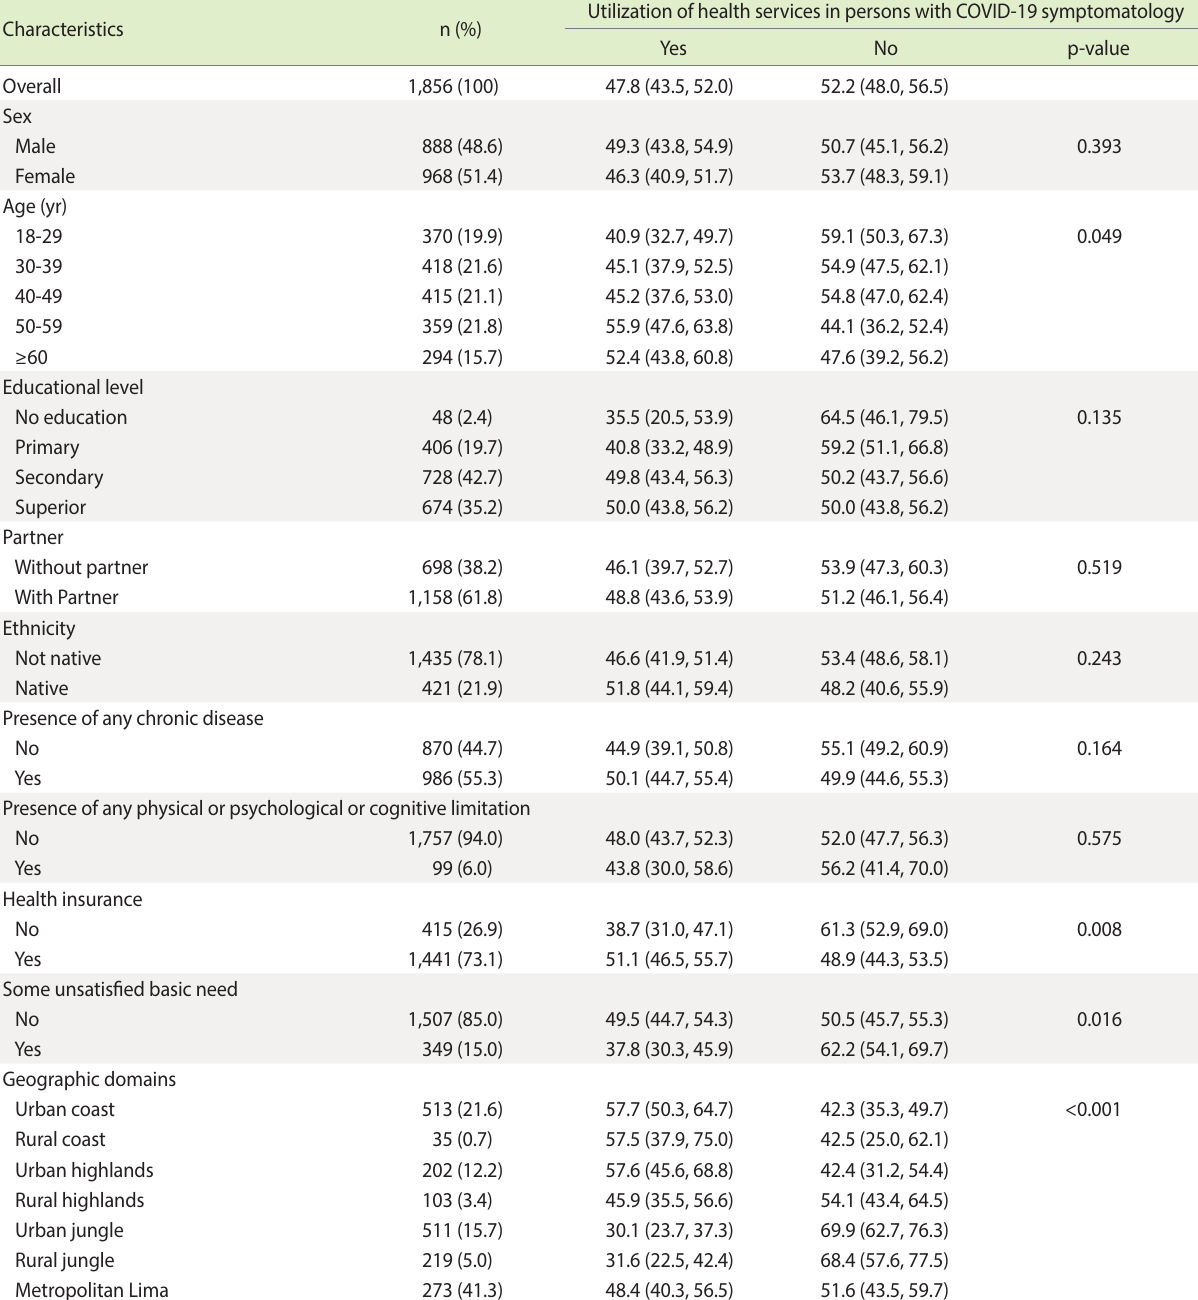
Table 1. Characteristics of the participants included in the study 1